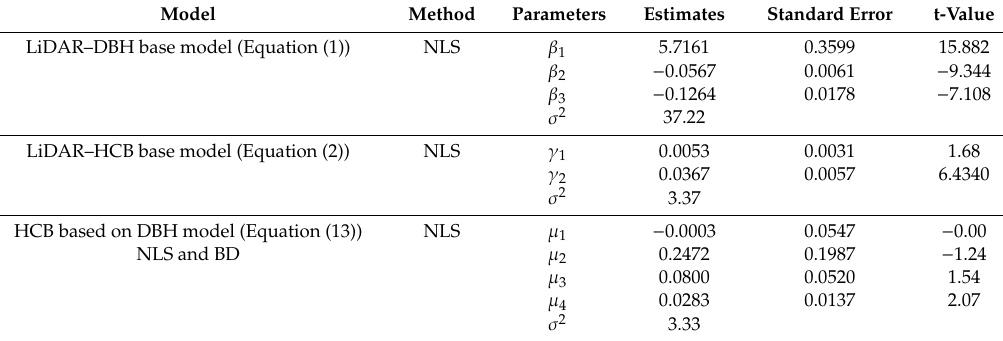
Table 2. Parameter estimates of the LiDAR–DBH base model (Equation (1)), the LiDAR–HCB base model (Equation (2)), and the NLS and BD model (Equation (13)), as well as the simultaneous equation system (Equation (3)). The first three models were estimated using ordinary least squares regression, and the last one was estimated using NSUR, 2SLS, 3SLS, and